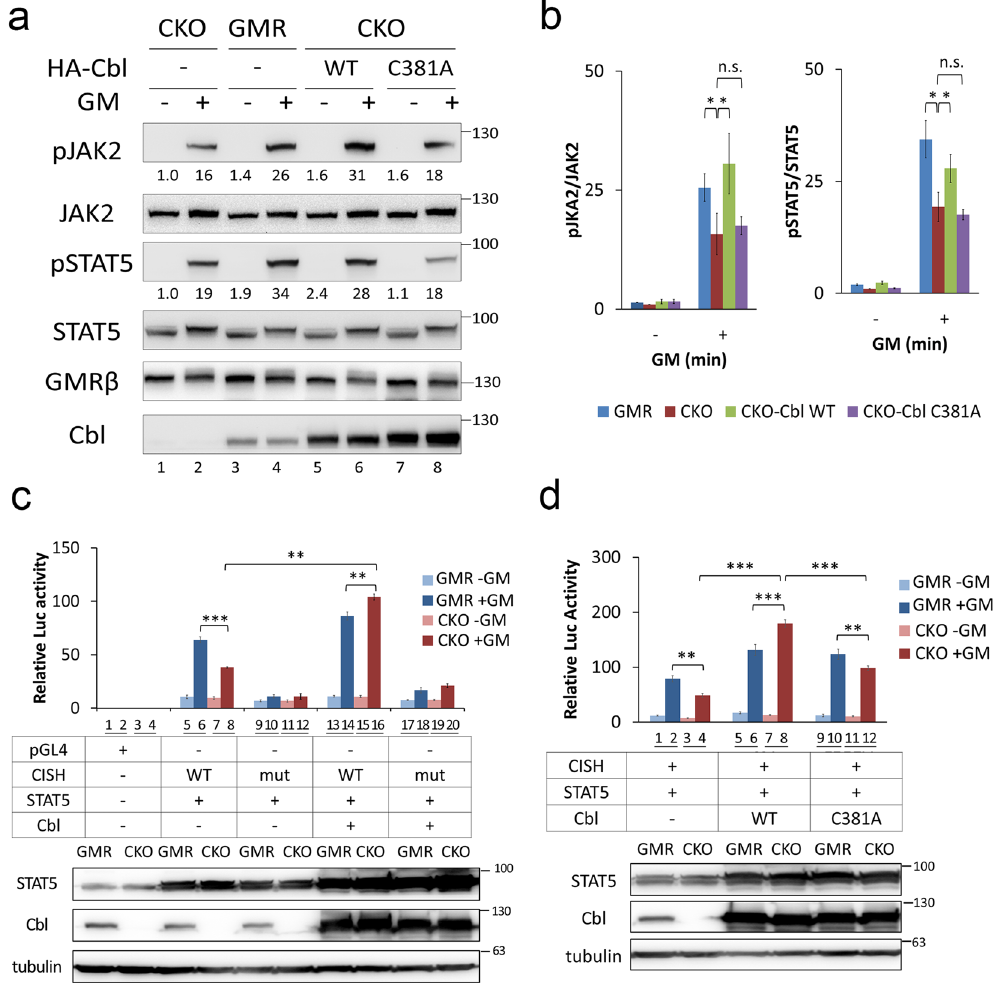
Figure 3. Cbl plays a positive role in GMR β /JAK2/STAT5 signal axis in cells. ( a , b ) Cbl affects cytokine-induced JAK2 and STAT5 activation in GMR αβ HeLa (GMR) cells. ( a ) HA-tagged Cbl (wide type or C381A, a ligase- deficient mutant) were transiently expressed in Cbl knockout GMR cells (CKO). After serum starvation for 16 h, transfected cells, as well as the parental GMR cells, were stimulated with ( + ) or without ( − ) GM-CSF (GM) (1 ng/mL) for 10 min, and their WCL were analysed by Western blot using the indicated antibodies. ( b ) Quantification of the data from ( a ). ( c ) Cbl promotes STAT5-driven CISH reporter activity upon GM-CSF stimulation. CKO and parental GMR cells were transiently co-transfected with the indicated wild-type (WT) or mutant (mut) CISH reporter genes and STAT5a without (lanes 5–12) or with (lanes 13–20) Cbl rescue. Transfected cells were treated with ( + ), or without ( − ), GM-CSF (GM) (1 ng/mL) for 24 h prior to performing the luciferase assay. The lower panel illustrates the protein levels of endogenous and overexpressed STAT5 and Cbl, as well as tubulin for normalization, in the various transfected cells. ( d ) The ubiquitin ligase activity of Cbl is required for rescuing STAT-dependent reporter activity. Cells were transfected and analysed as described in ( c ), except that cells were rescued with WT Cbl (lanes 5–8) or a ubiquitin E3 ligase dead mutant (C381A Cbl) (lanes 9–12). In ( c ) and ( d ), the relative luciferase values in the upper panel are presented as mean ± SEM. All experiments were repeated three times. Statistical significance ( * P < .05, ** P < 0.01 and *** P < 0.001) was determined by